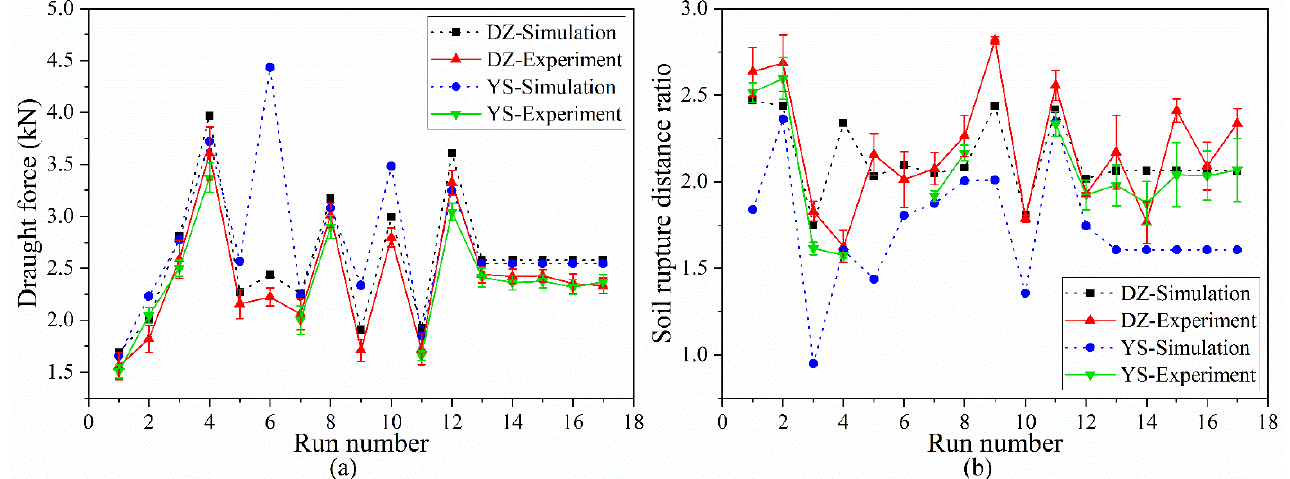
Figure 11. Comparisons of the simulated results with the experimental results for the draught force ( a ) and soil rupture distance ratio ( b ).